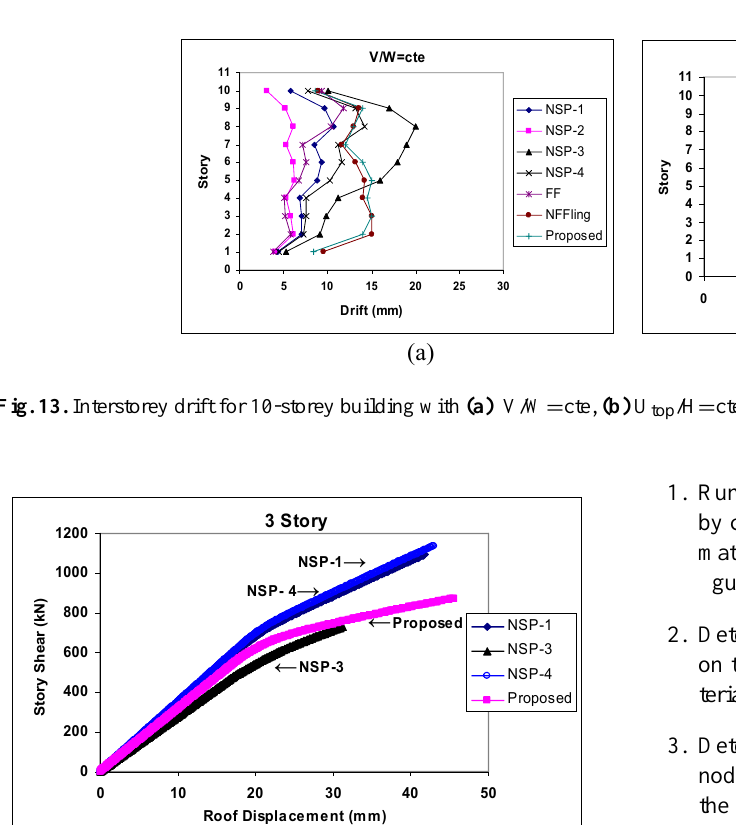
Figure 12. Interstorey drift for 6-storey building with (a) V/W=cte, (b) U Fig. 12. Interstorey drift for 6-storey building with (a) V/W = cte, (b) U top /H = cte.